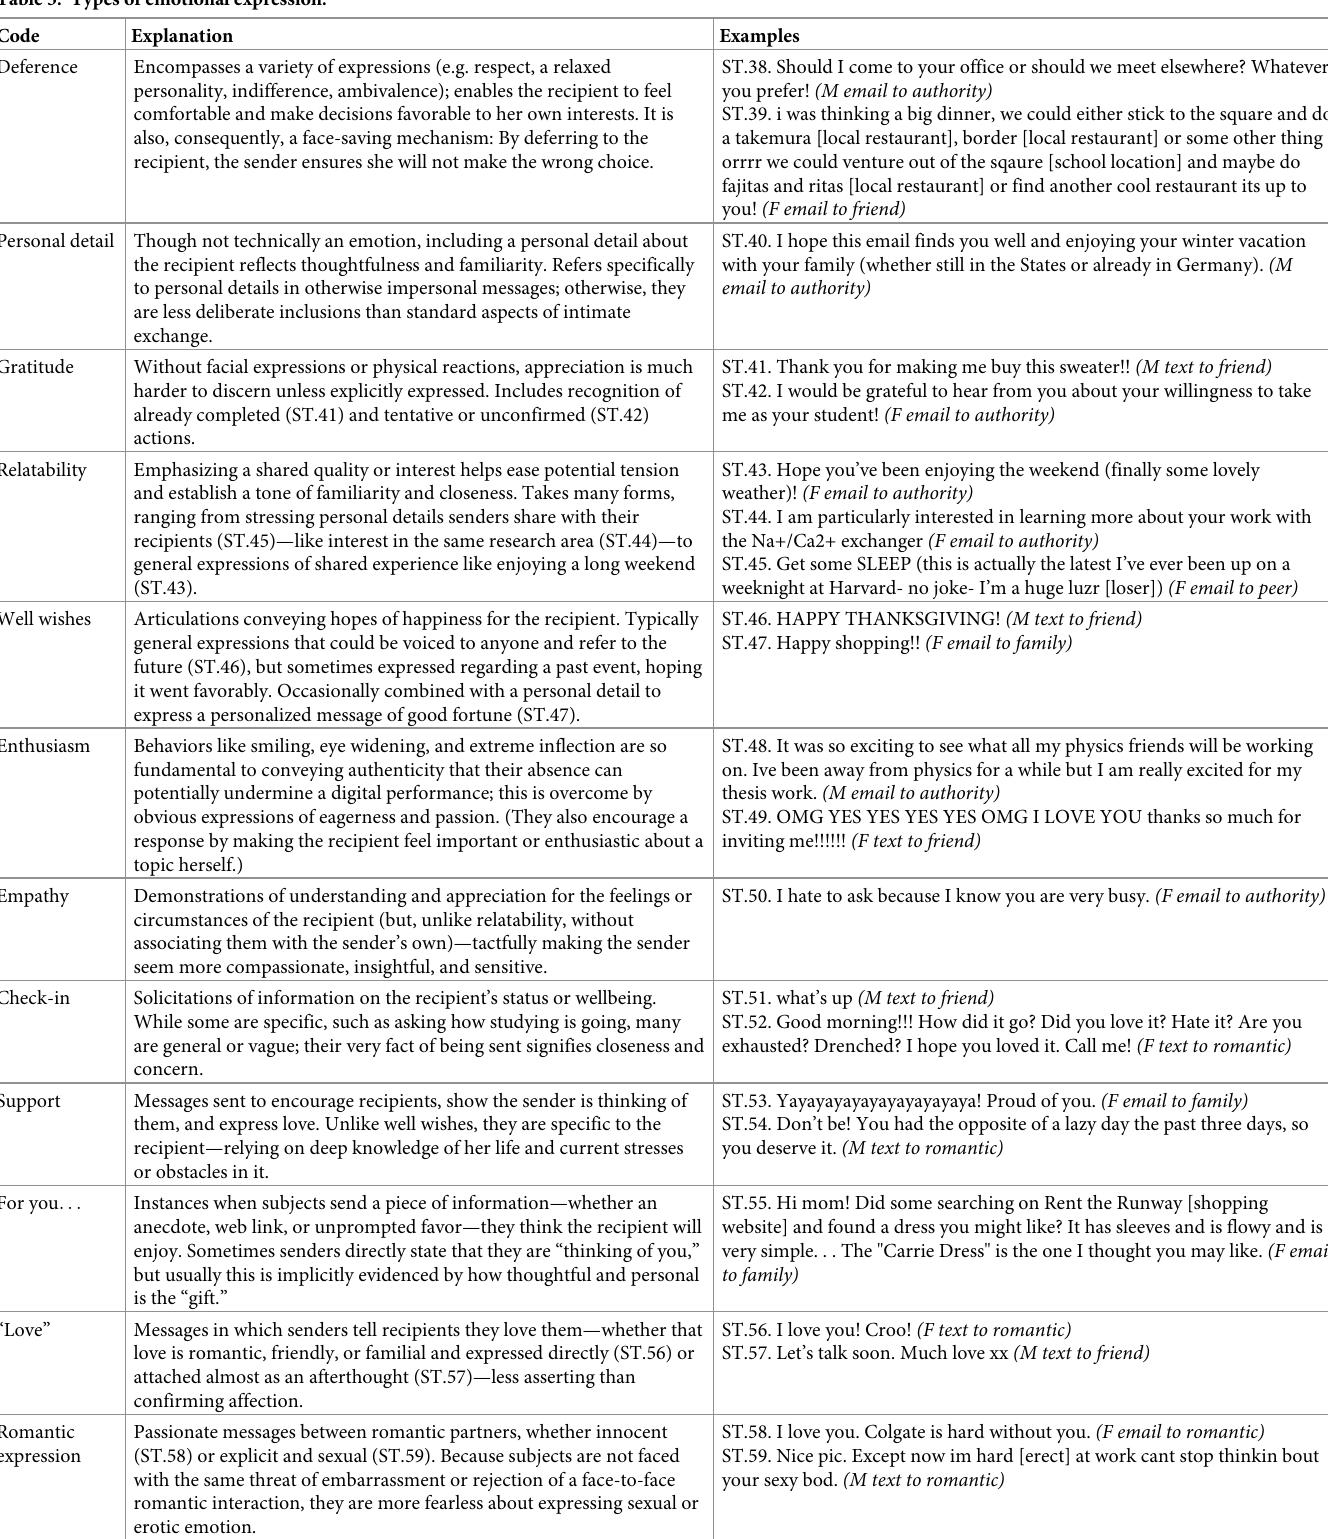
Table 3. Types of emotional